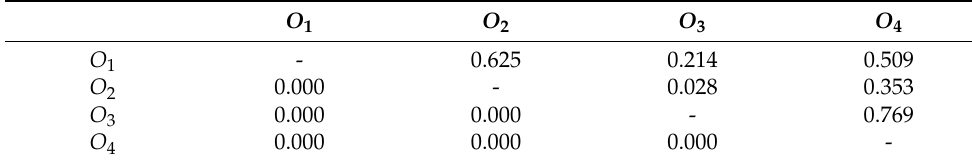
Table 25. The total dominance matrix (Ke and Chen, 2012).